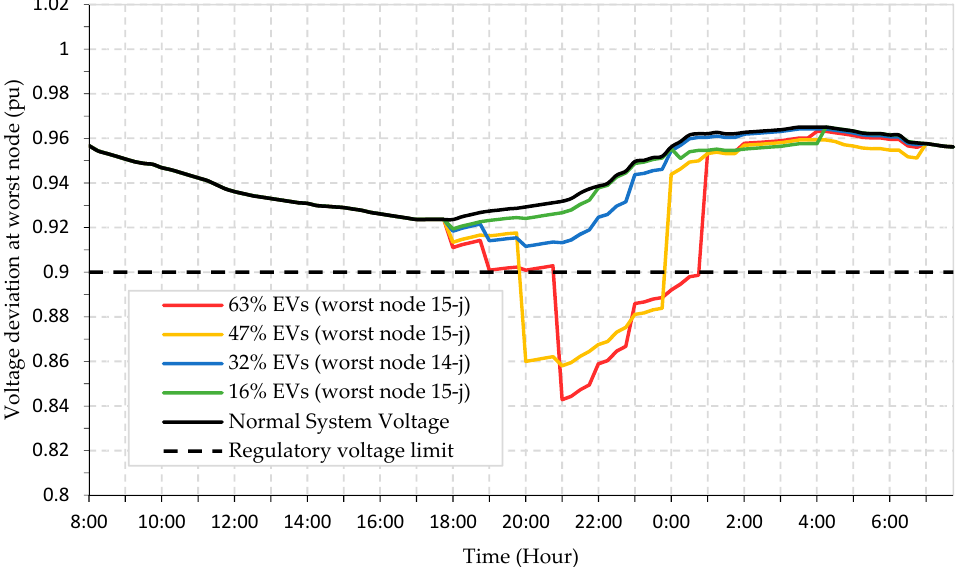
Figure 7. Impact of random uncoordinated EVs’ charging within 18:00–07:00 h on system voltage.